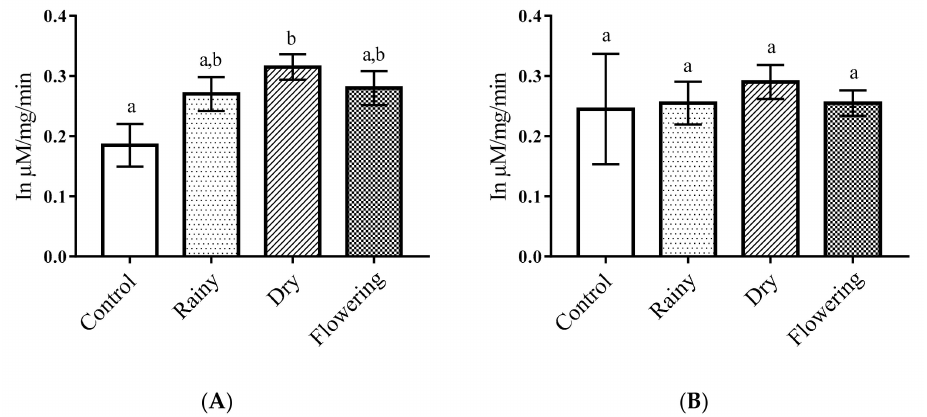
Figure 4. Biochemical changes in acid phosphatases of Ae . aegypti and Ae . albopictus larvae. Changes in acid phosphatases levels between Ae . aegypti ( A ) and Ae . albopictus ( B ) larvae treated and not treated with the essential oils of Lippia grata . Different lowercase letters in the bar denote significant difference ( p < 0.05). Bars represent standard deviations ( n = 3). Values estimated by one-way ANOVA followed by the Tukey test. Control, untreated